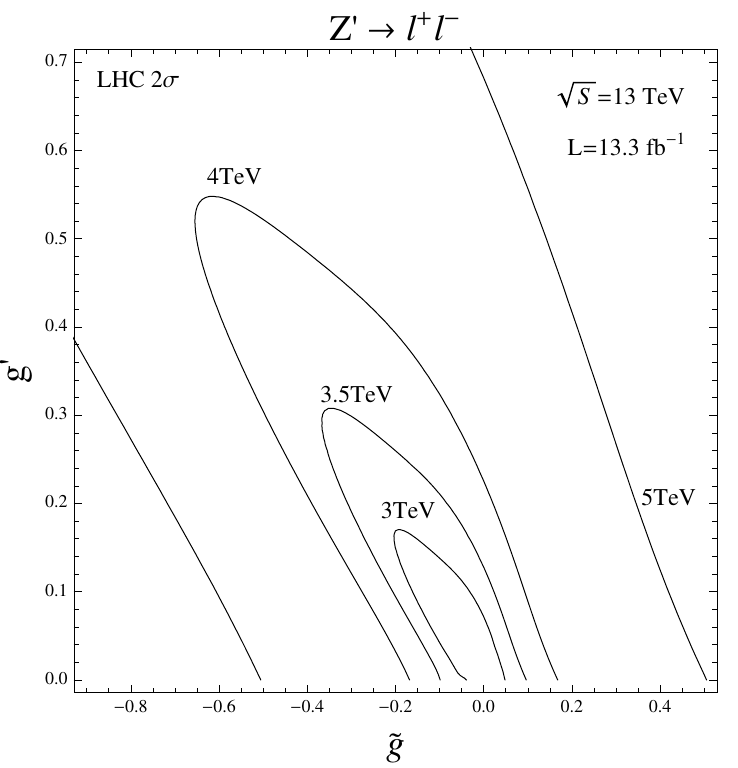
Figure 2. Significance analysis for the di-lepton ( l = e, µ ) DY channel at the LHC for different Z ′ - boson masses. Acceptance cuts for the electron and muon channels are applied and the correspond- ing efficiency factors are included. The two channels are then combined and the limits are